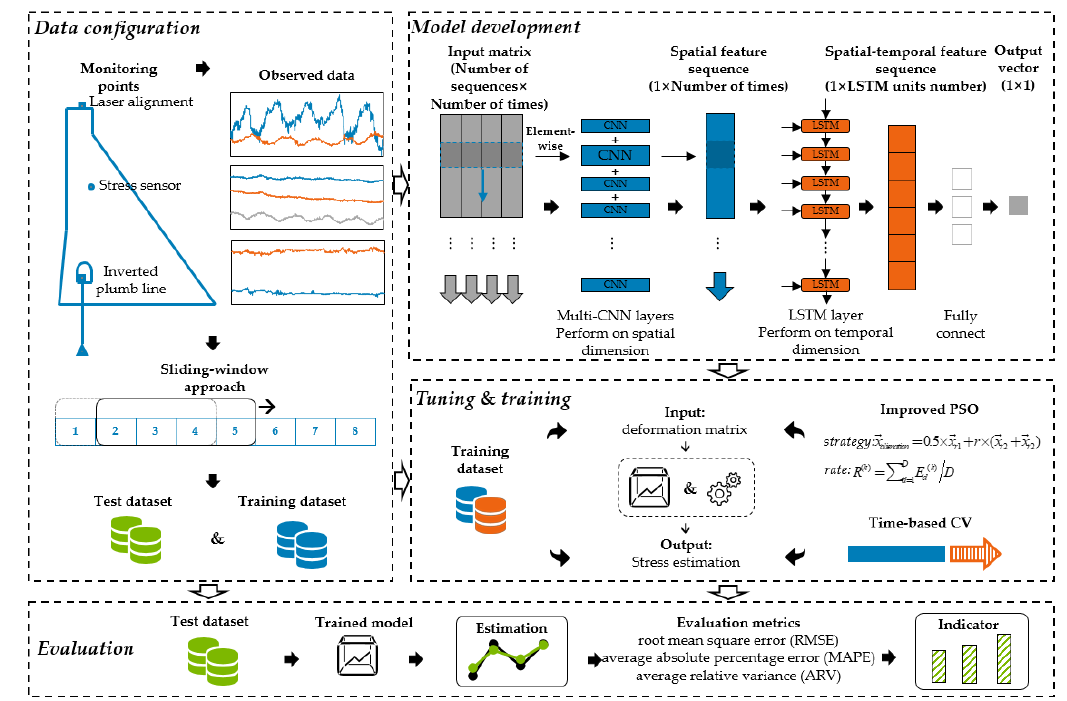
Figure 1. The process of the presented estimation model.